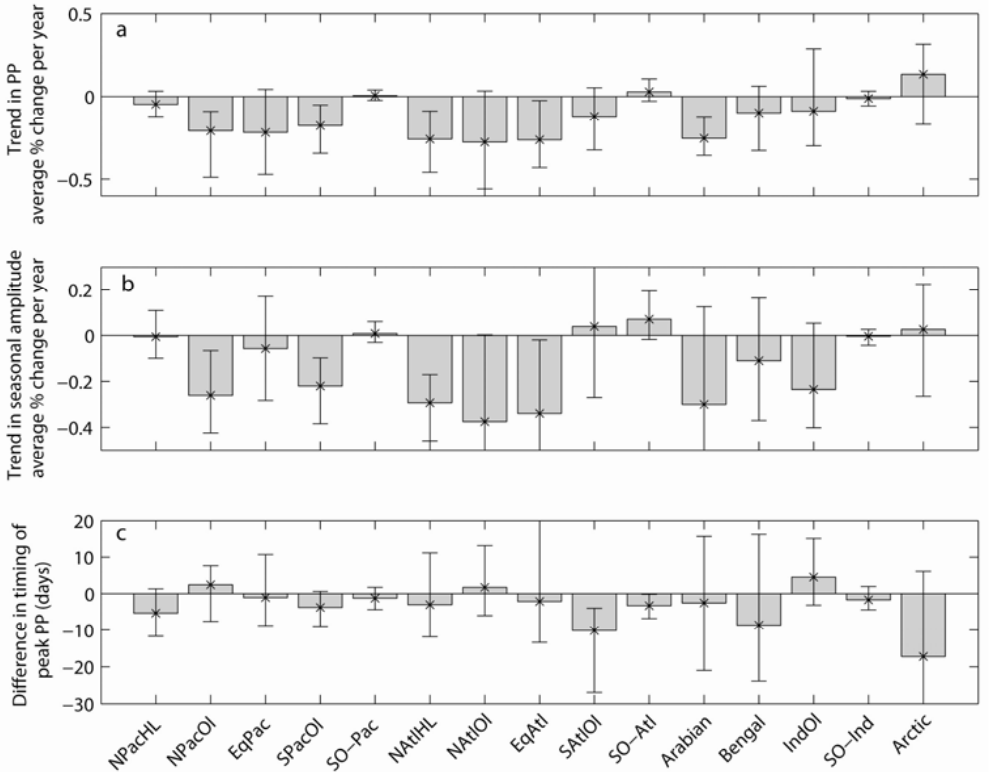
Fig. 5. Biome mean trends and standard deviations for 6 models forced with IPCC AR5 scenario RCP8.5 until 2100. (a) Primary production Figure 5: Biome mean trend and standard deviation for 6 models forced with IPCC (PP), (b) seasonal amplitude of PP and (c) timing of peak PP (where negative values indicate earlier timing of peak PP). Biome labels indicate (left to right) high-latitude North Pacific, oligotrophic North Pacific, equatorial Pacific, oligotrophic South Pacific, Southern Ocean – AR5 scenario RCP8.5 to 2100. a) primary production (PP), b) seasonal amplitude of Pacific, high-latitude North Atlantic, oligotrophic North Atlantic, equatorial Atlantic, oligotrophic South Atlantic, Southern Ocean – Atlantic, Arabian Sea, Bay of Bengal, oligotrophic Indian Ocean, Southern Ocean – Indian, and Arctic Ocean (see Henson et al., 2010, for biome